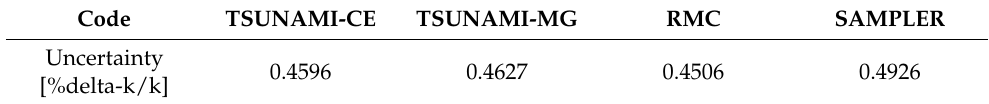
Table 10. Total uncertainty in k eff